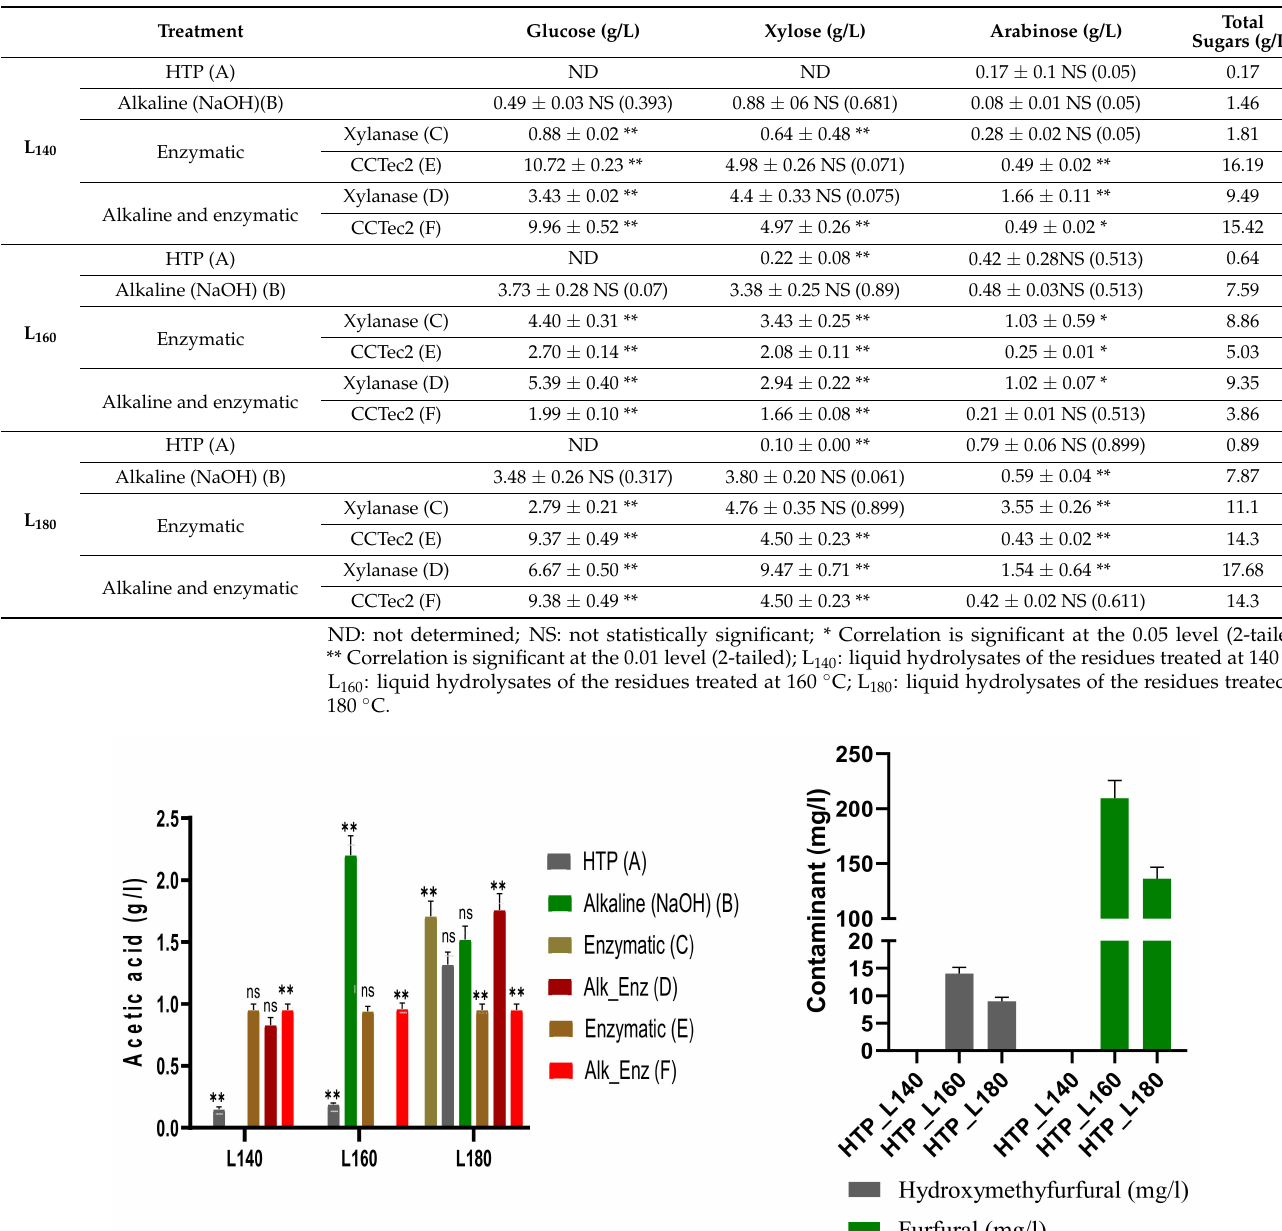
Table 2. Sugar yields in the hydrolysates after HTP, alkaline and enzymatic treatments of the solid residues.